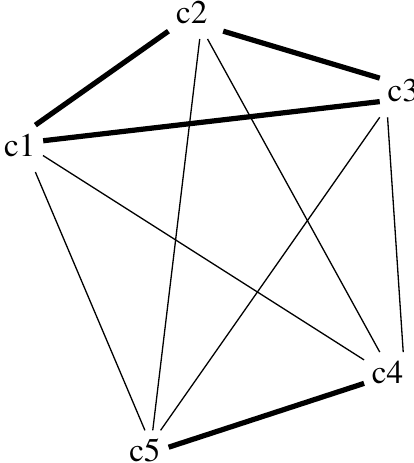
Figure 1. Graph representing matrix A in Example 1. Each criteria is a node in the graph. Edges represent the non-zero values in the matrix. Thick edges represent a value of 0.9 in